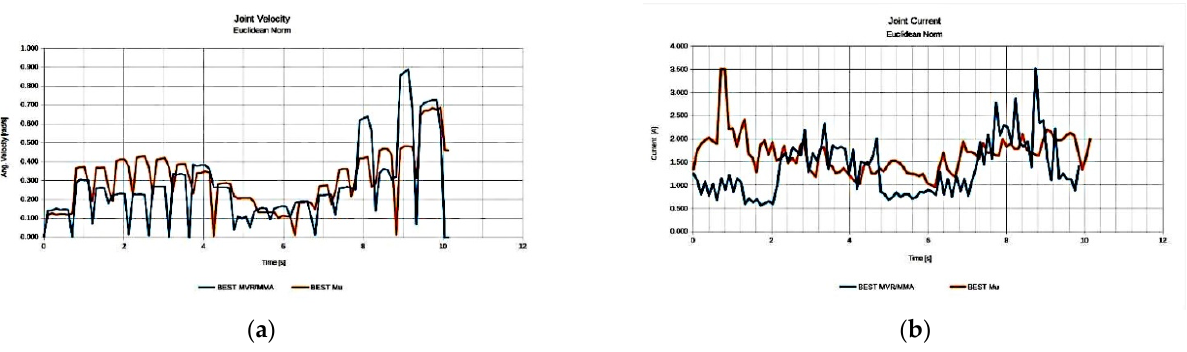
Figure 24. Comparison of the required joint velocities ( a ) and joint current usage ( b ) for the best anatomies under each performance index for Task 4.